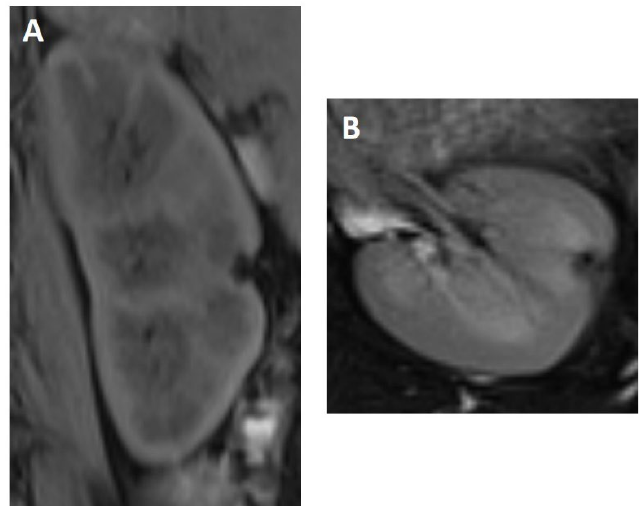
Figure 4. Postoperative 1-year follow-up shows a small parenchymal defect in the midline of the left kidney without evidence of recurrence (T1 coronal with fatsat ( A ) and T2 axial with fatsat ( B )).